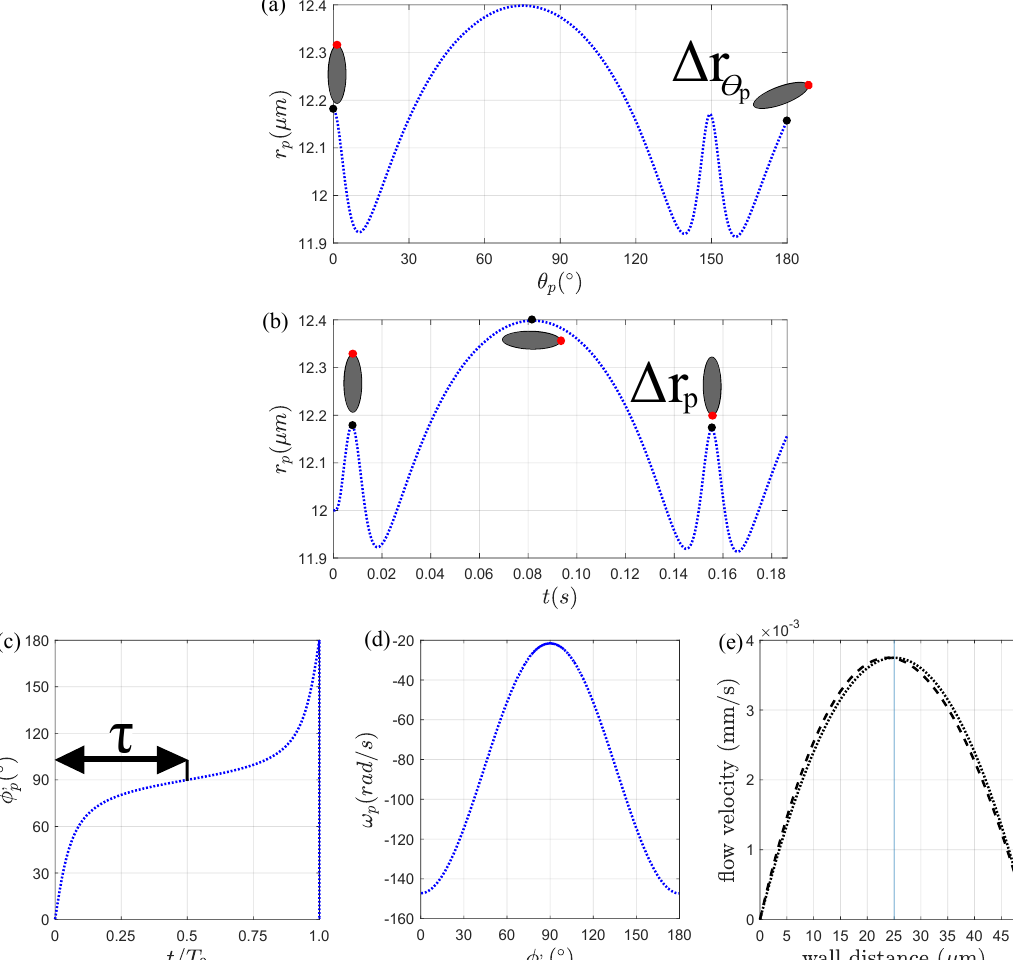
Figure A5. Translation and rotation of an elliptical particle in the absence of a magnetic field. The particle has an aspect ratio AR = 4 and the initial radial position is r p 0 = 12 µ m, whereas the initial particle direction is φ p 0 = 43 ◦ in the beginning of the simulation. The channel’s average radius is R avg = 175 µ m. The particle-wall distance is studied with respect to its ( a ) θ p position; ( b ) time, t, in the curved channel; ( c ) the evolution of the orientation angle φ (cid:48) p with respect to dimensionless time t / T 0 ; ( d ) the rotational velocity ω p versus φ (cid:48) p ; and ( e ) the velocity profiles for a curved channel (dashed line) and straight channel (dotted